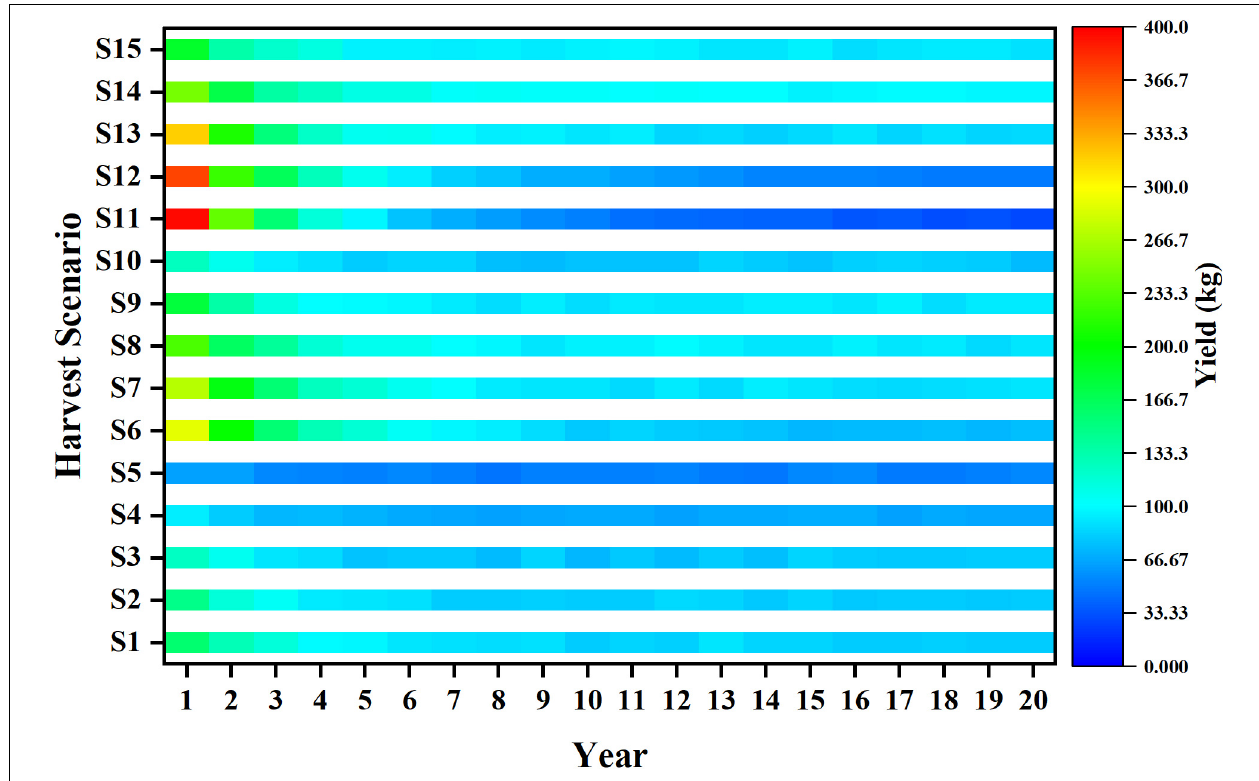
FIGURE 7 | Trends of yield in different harvest